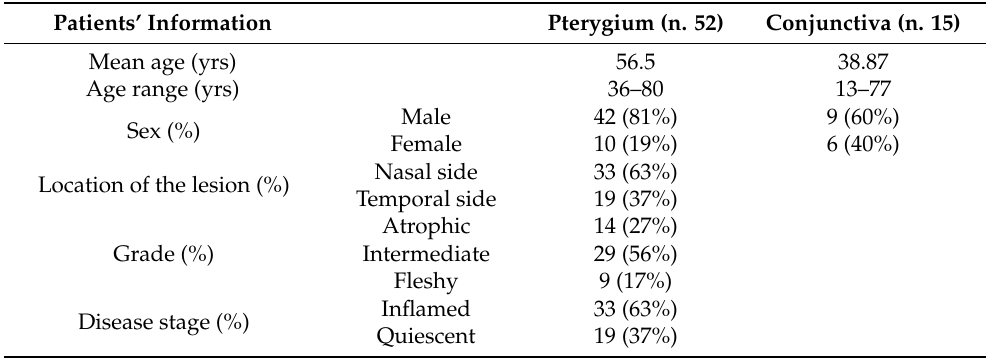
Table 2. Clinical features of patients.